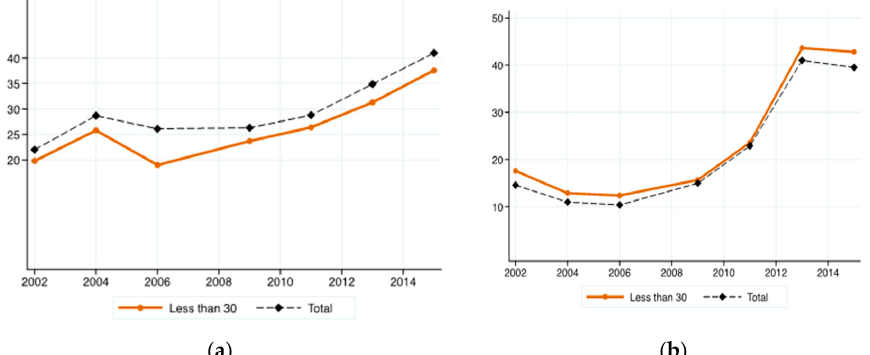
Figure 4. Young people interested in politics and dissatisfied with democracy. ( a ) Interest in politics, measured as the percentage of individuals very or quite interested in politics; ( b ) dissatisfaction with democracy, measured as the percentage of individuals with low satisfaction with the way in which democracy works in Spain (0–3 on a 0–10 scale). Source: European Social Survey, rounds 1–7 (Spain).